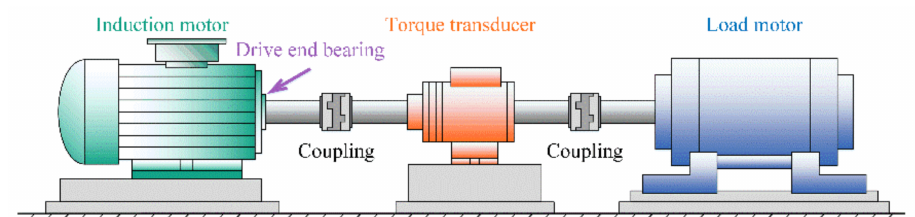
Figure 5. The CWRU bearing test rig.